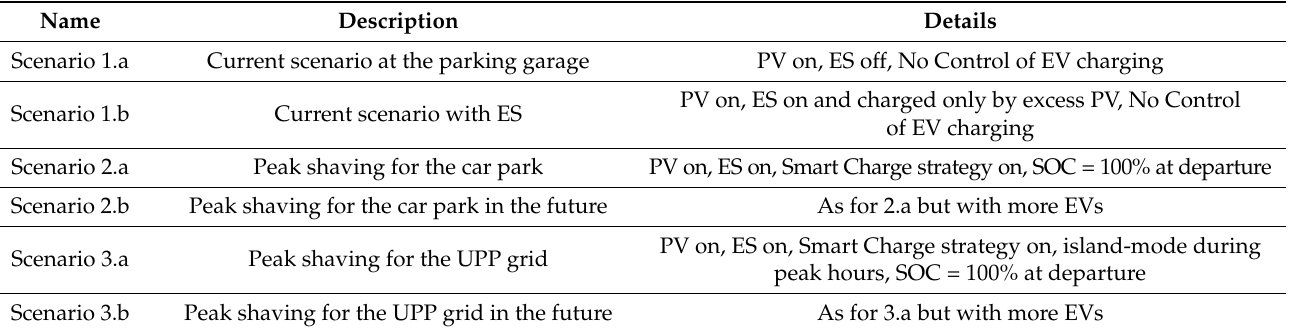
Table 3. Summary of the simulation